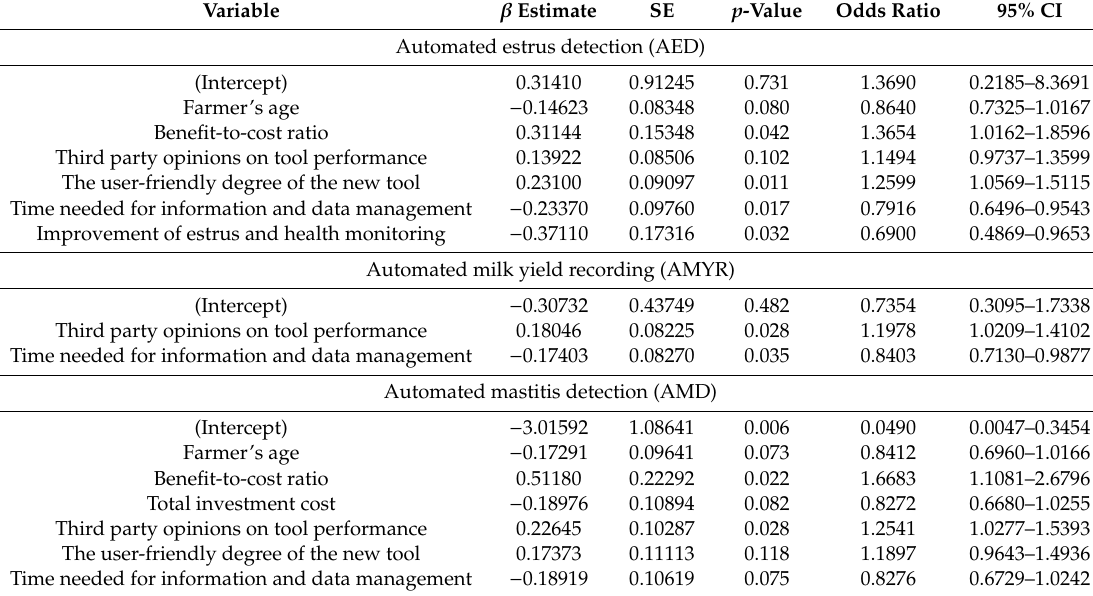
Table 4. Logistic regression output and obtained odds ratio for the prediction of the presence of a tool for automated estrus detection (AED), milk yield recording (AMYR), and mastitis detection (AMD) in the farms, as determined by the analysis of individual convenience